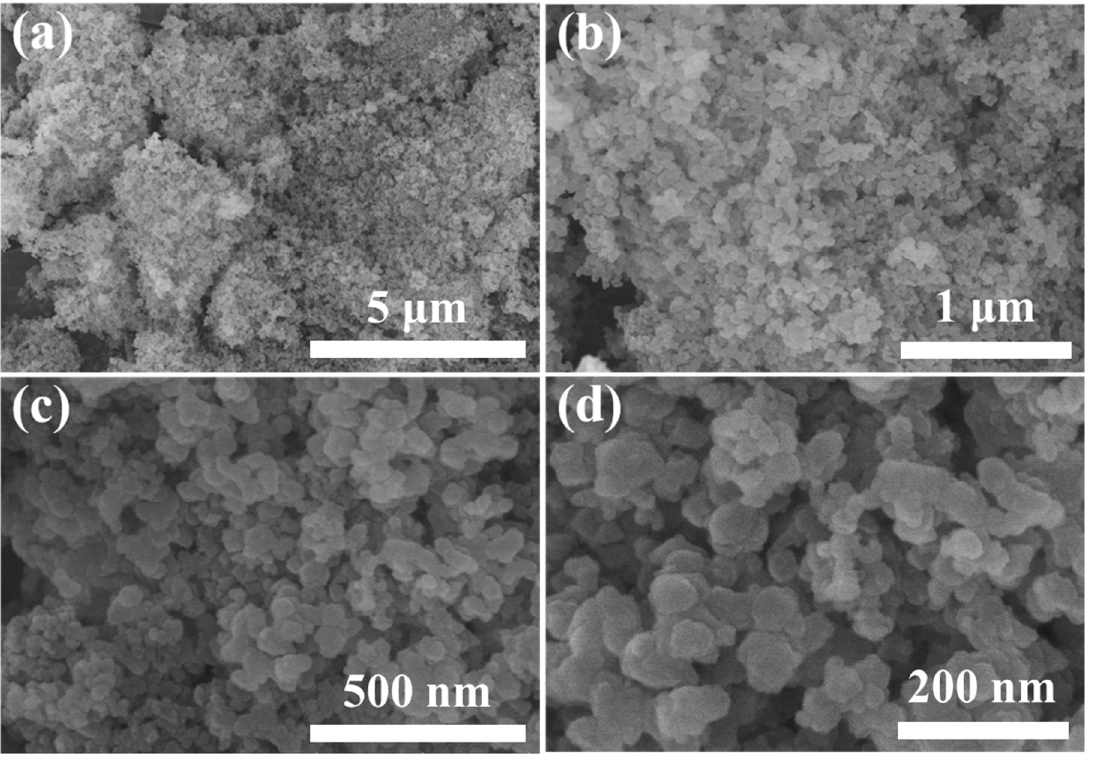
Figure 2. HR-FESEM images of FA_SiO 2 synthesized from raw fly ash in this study at different op- tical magnifications. optical